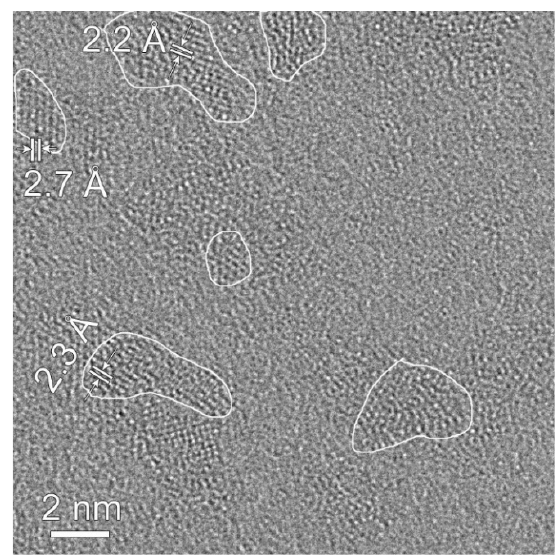
Figure 28. Unusual temperature dependencies of the relative areas for spectral components 1 ( a ), 2 ( b ), 3 ( c ), 4 ( d ) and 5 ( e ) and normalized total spectrum areas ( f ) obtained within the new heteroge‑ neous iron core model used for fitting the Mössbauer spectra of Ferrum Lek ( □ ), Maltofer ® ( ▲ ) and Ferrifol ® ( • ). Data were taken from Refs. [49–51].